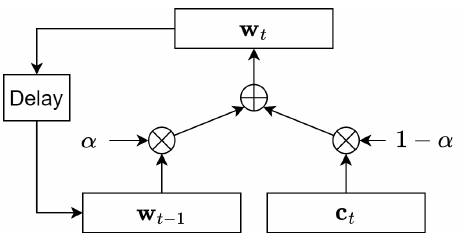
Figure 3. In the RIC method, the item weight vector w t at any time step t is generated by a first order linear recurrent model. The input to the model is the current confidence vector c t